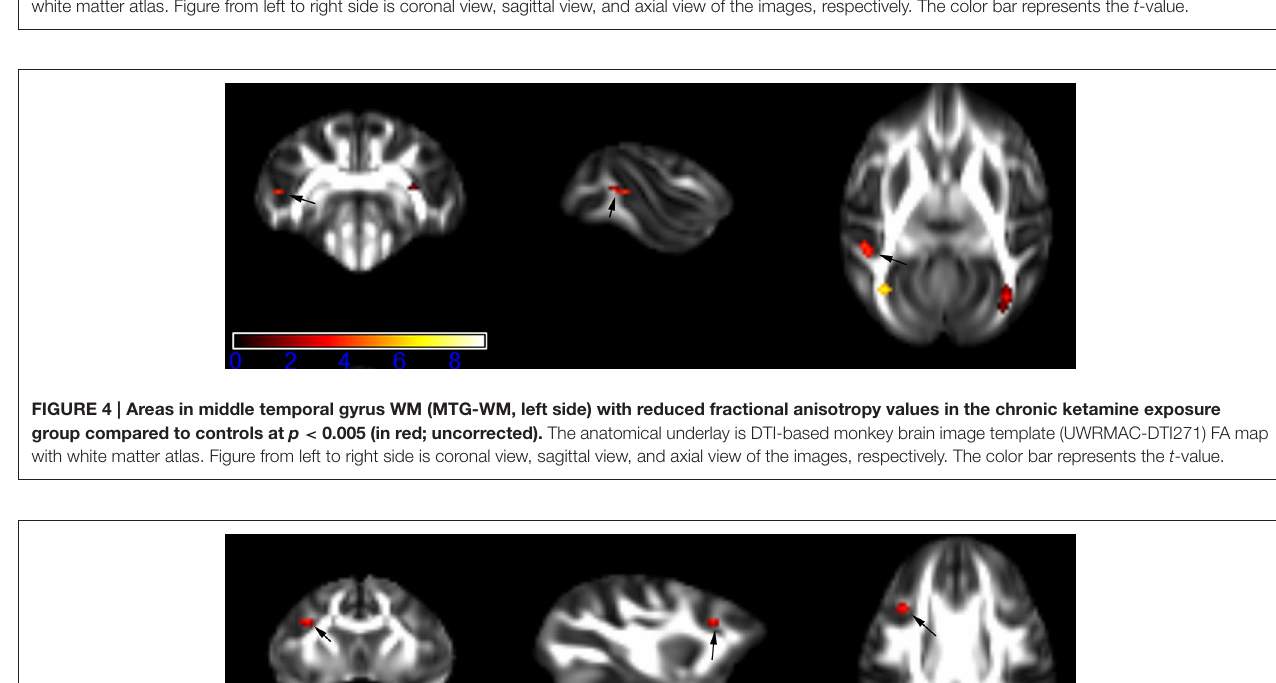
FIGURE 3 | Areas in posterior thalamic radiation (PTR, left side) with reduced fractional anisotropy values in the chronic ketamine exposure group compared to controls at p < 0.005 (in red; uncorrected). The anatomical underlay is DTI-based monkey brain image template (UWRMAC-DTI271) FA map with white matter atlas. Figure from left to right side is coronal view, sagittal view, and axial view of the images, respectively. The color bar represents the t -value.